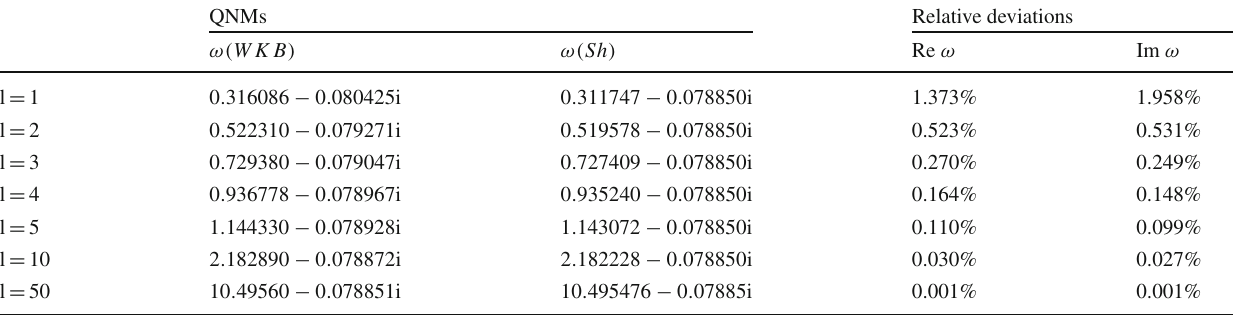
Table 4 The QNMs derived by the WKB approximation approach and shadow radius and the relative deviations. In the calculation, we let Q = 0 . 1 and α = 0 .